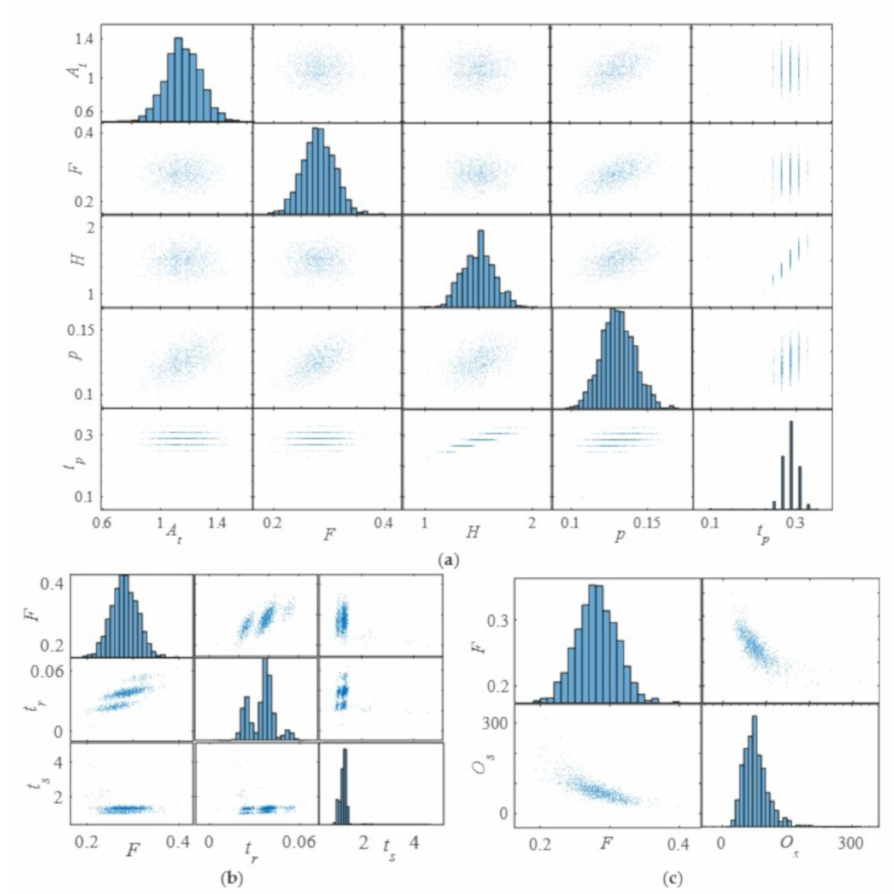
Figure 11. The influence of the wind − solar − hydro system parameters on the DPIs of the guide vane opening of PSPP. ( a ) The influence of At , F and H on the peak value and peak time. ( b ) The influence of F on the rise time and settling time. ( c ) The influence of F on the overshoot.